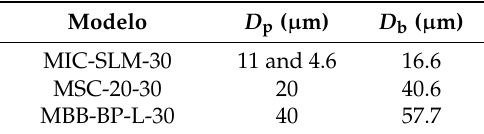
Table 4. Diameter of the microbubbles ( D b ) generated in relation to the internal diameter of the micropipettes ( D p ).